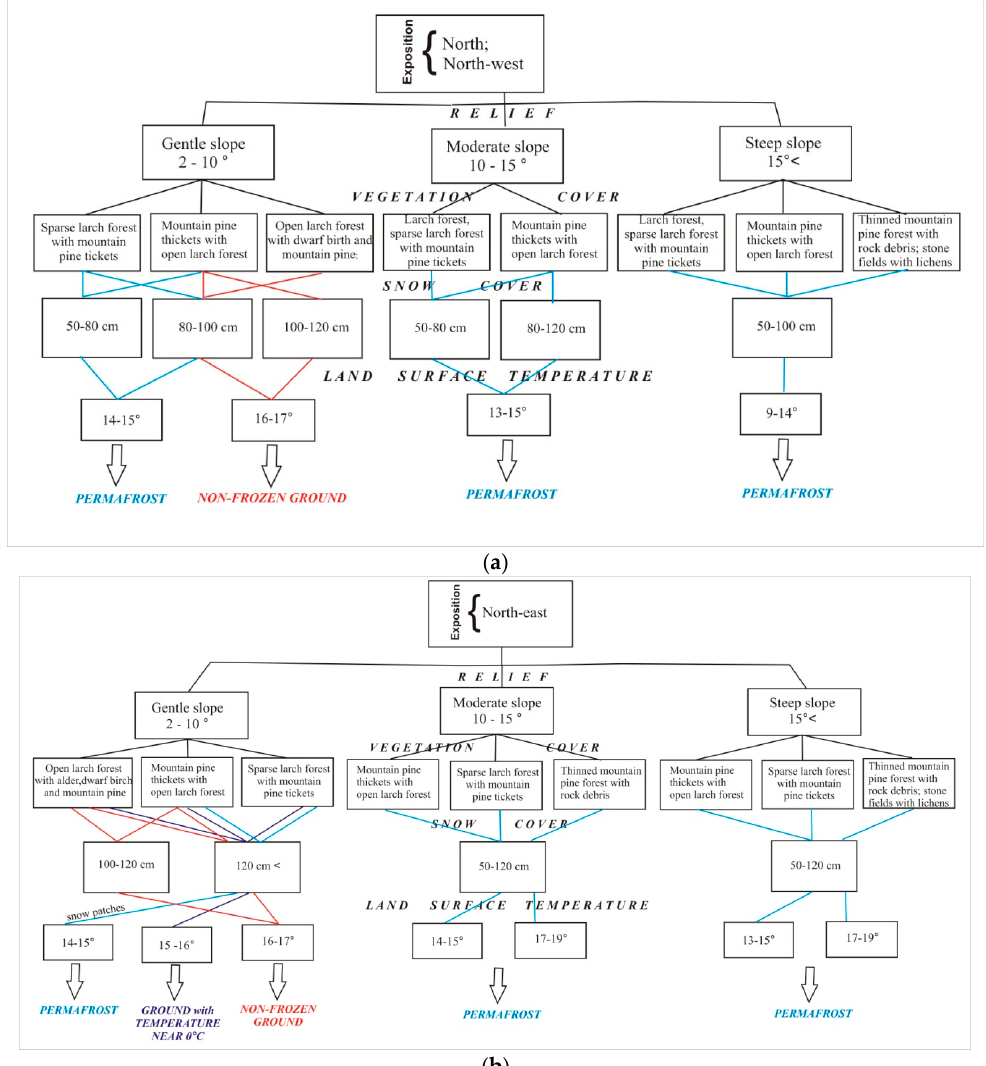
Figure 6. ( a ) Example of the compilation of the scheme for identifying permafrost and unfrozen ground in windward north and north ‐ west slopes, Elkon Massif. ( b ) Example of the compilation of the scheme for identifying permafrost, ground with temperature near 0 °C and unfrozen ground in north ‐ eastern slope, Elkon Massif.